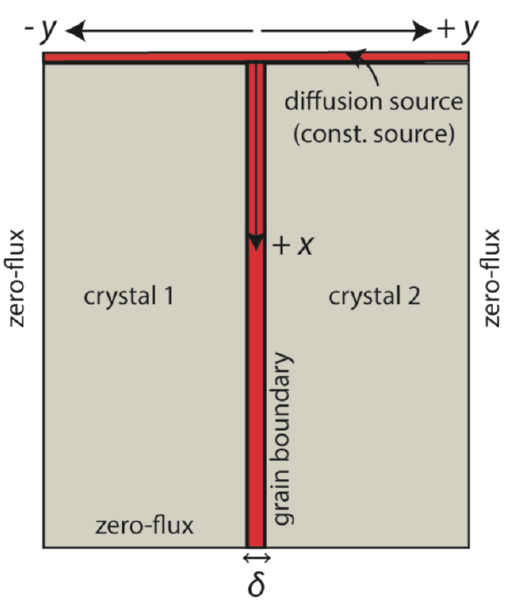
Figure 2. Diffusion model with the definition of variables and nu- merical boundary conditions. The grain boundary has an assigned grain boundary width δ . Within the region of the grain boundary, Eq. (3) is solved and D gb is obtained. In the crystal interiors (crys- tal 1 and crystal 2), Eq. (1) is solved to determine D vol